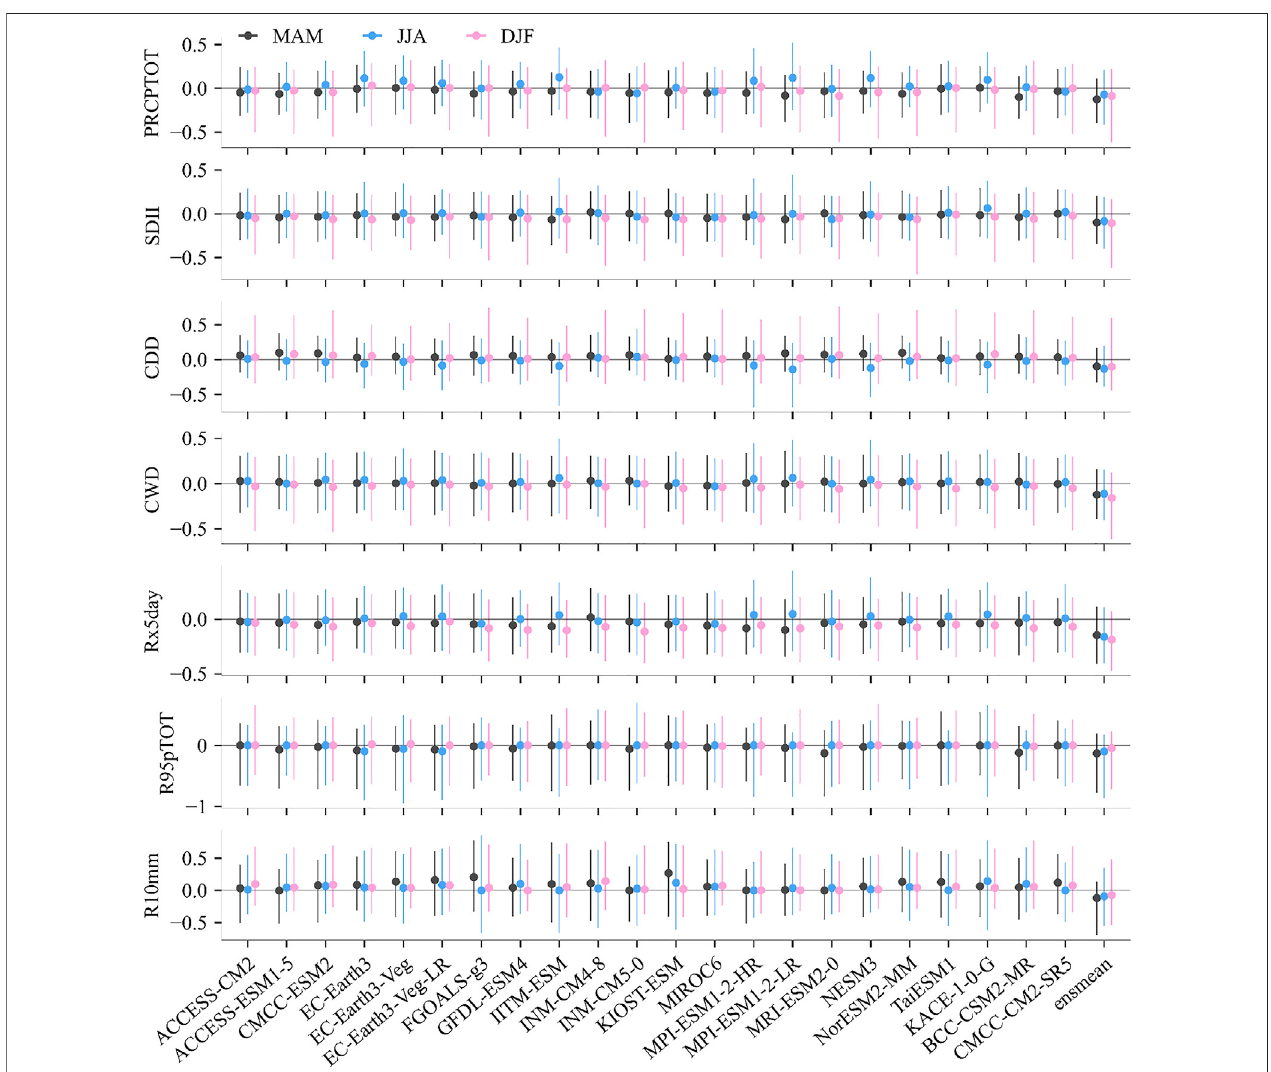
FIGURE 3 | Percentage difference in L-skewness ( τ 3 ) of total precipitation and extreme precipitation indices between the GPM and CMIP6 models (including the multi-modelensemblemean) inspring(MAM), summer(JJA), andwinter(DJF). Thetotalprecipitationand SDII, CDD, CWD,Rx5day, R95pTOT, and R10mm areshown from top to bottom. The point represents the median, and the error bar indicates the 90% empirical con fi dence interval. The trianglein the graph indicates a bias greater than 150%.